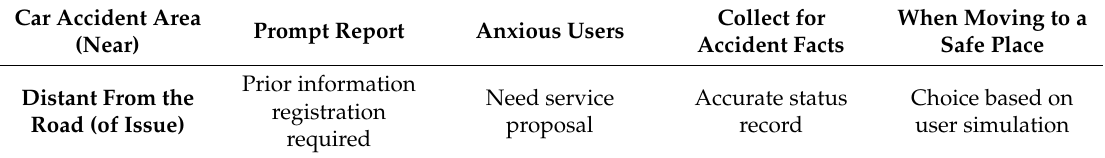
Figure 5. Affinity map: Information from the sensor robot and mobile app to find out the users’ needs, and the user journey map (right side, for persona) facing sensor robot, in the highway/roads